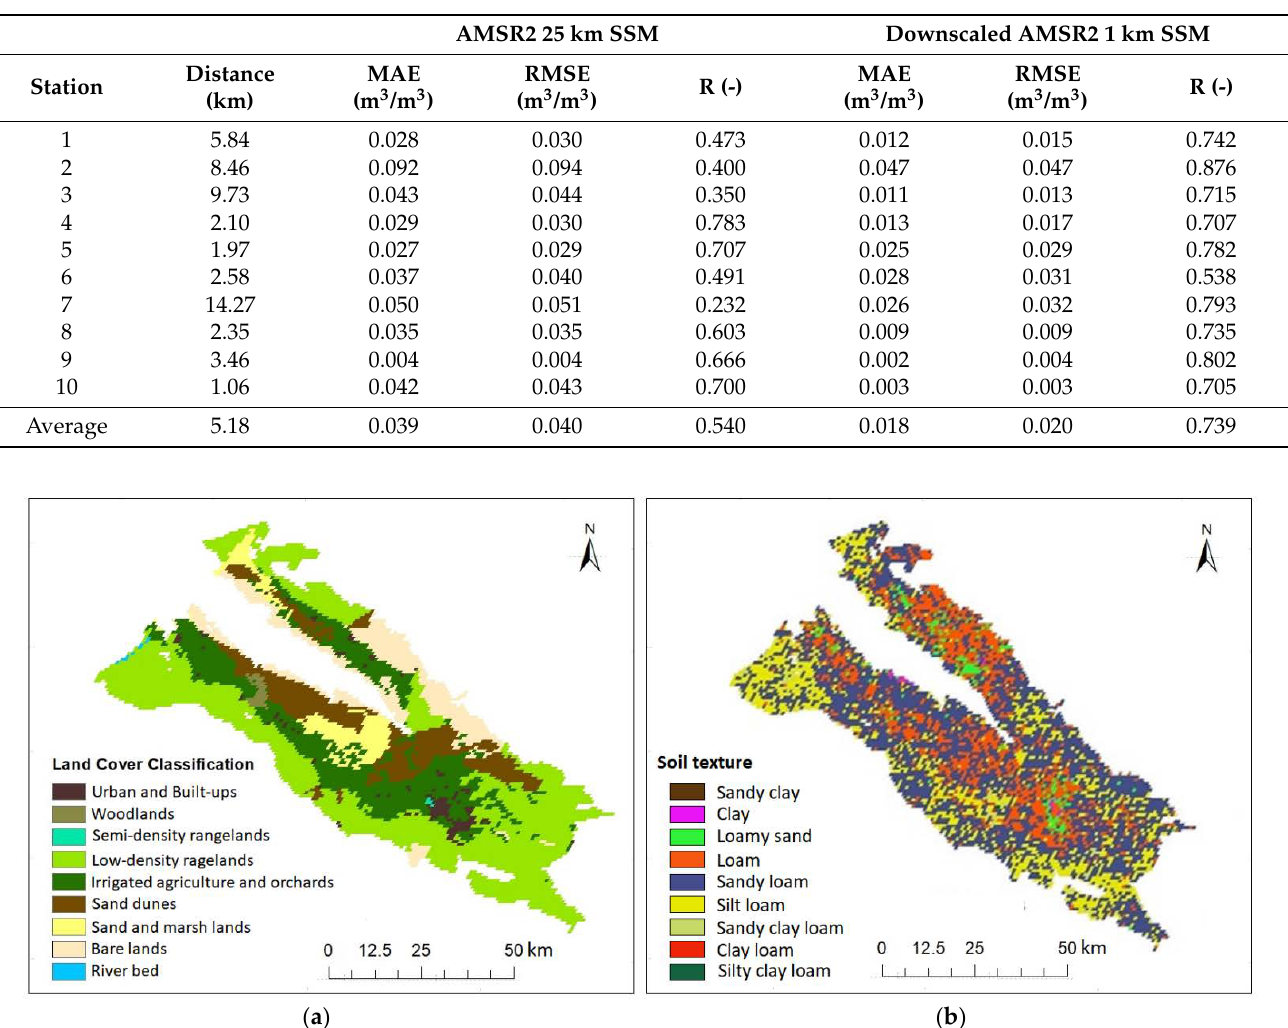
Table 4. Basic statistics for each station for the comparison between the AMSR2 25 km SSM and downscaled SSM with ground-based SSM.